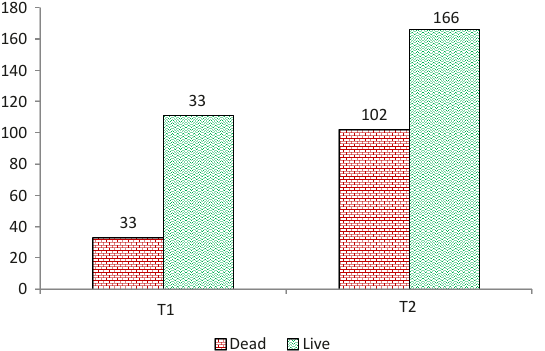
Figure 3. Live and dead (Road killed) butterflies recorded along the two